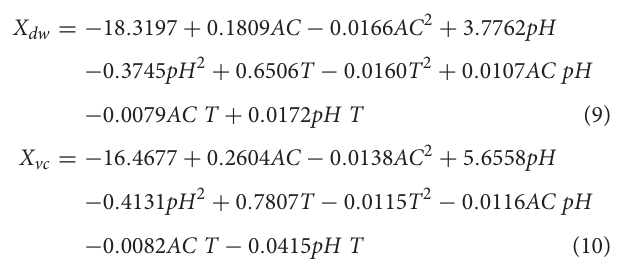
A p (lack of fit) < 0.0001 indicates the adequacy of the models, Eqs (9) and